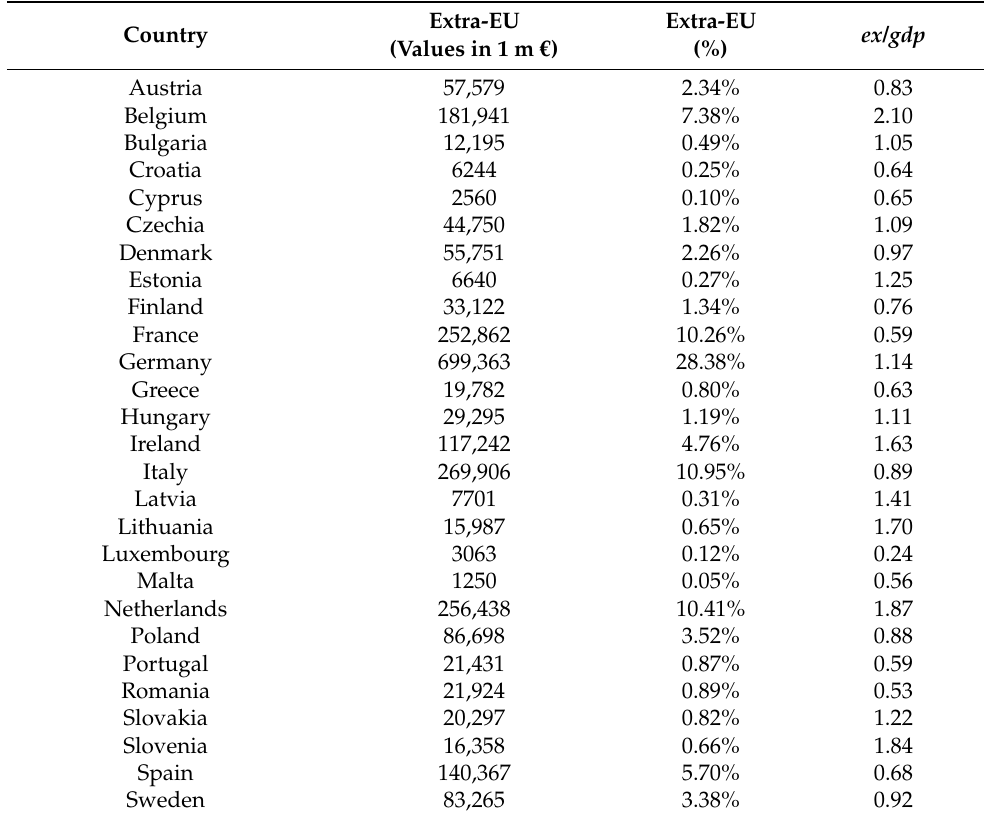
Table 10. EU external trade statistics (Extra-EU) and derived data.